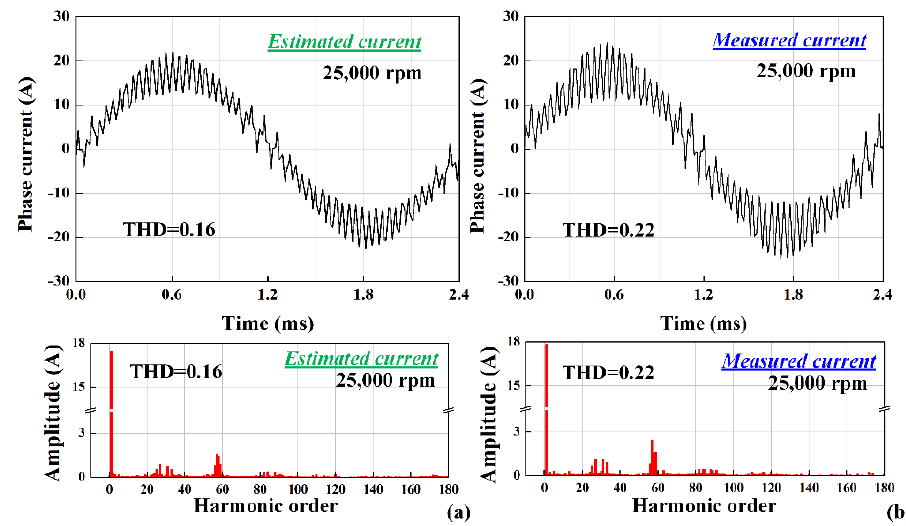
Figure 4. Comparison of current waveforms and fast Fourier transform (FFT) analysis results: ( a ) estimated and ( b ) measured currents.